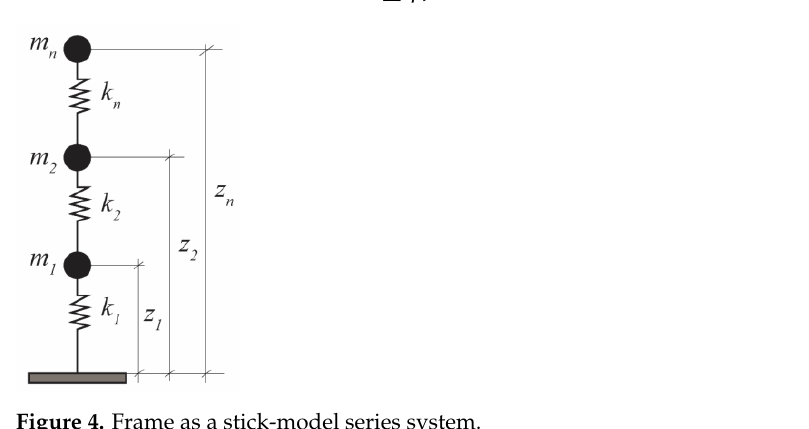
Figure 4. Frame as a stick-model series system.